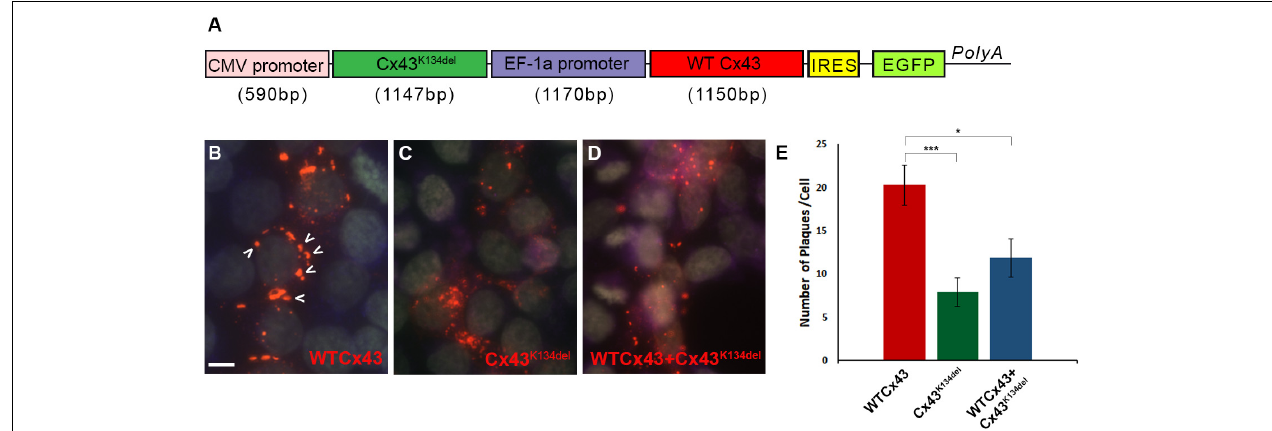
FIGURE 4 | Dominant-negative effects of Cx43 K134del on WT Cx43. Diagram of the expression cassette that carries both WT Cx43 and Cx43 K134del (A) . Representative images of immunostained HeLa cells expressing WT Cx43 (marked with arrows) (B) or Cx43 K134del (C) or co-expressing WT Cx43 along with Cx43 K134del (D) . Scale bar = 10 µ m. Quantification of plaques formed in the transfected cells (E) shows significant reduction of the number of plaques formed by Cx43 K134del compared to WT Cx43. Importantly, the number of plaques formed on cells expressing WT Cx43 along with Cx43 K134del were significantly lower than on the WT Cx43 transfected cells (* p < 0.05, *** p < 0.001, one way ANOVA with Bonferroni post hoc test was used). Standard error of the mean (SEM) is shown in the